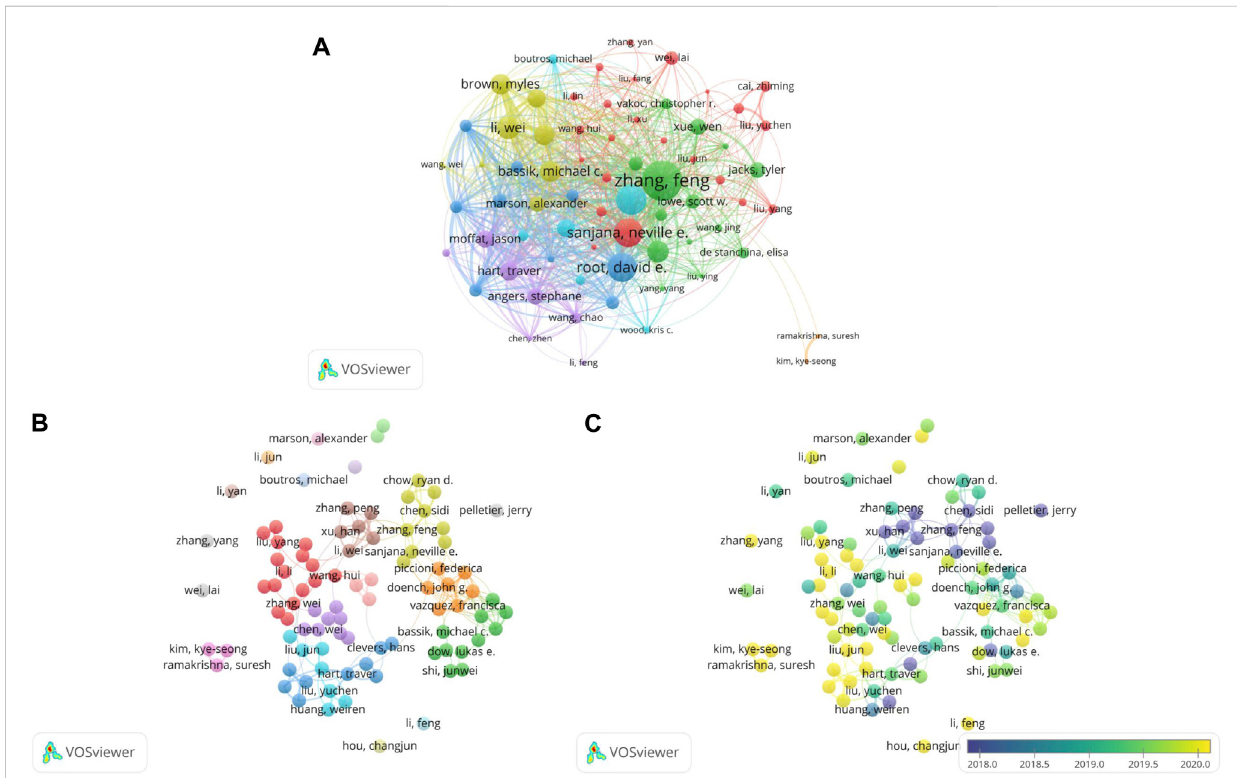
FIGURE 3 Bibliometric analysis of leading authors and co-authorships in the fi eld of CRISPR in cancer. (A) The citation analysis of leading authors. (B) Network visualization map of the leading authors collaboration. (C) Overlay visualization map of the leading authors collaboration.